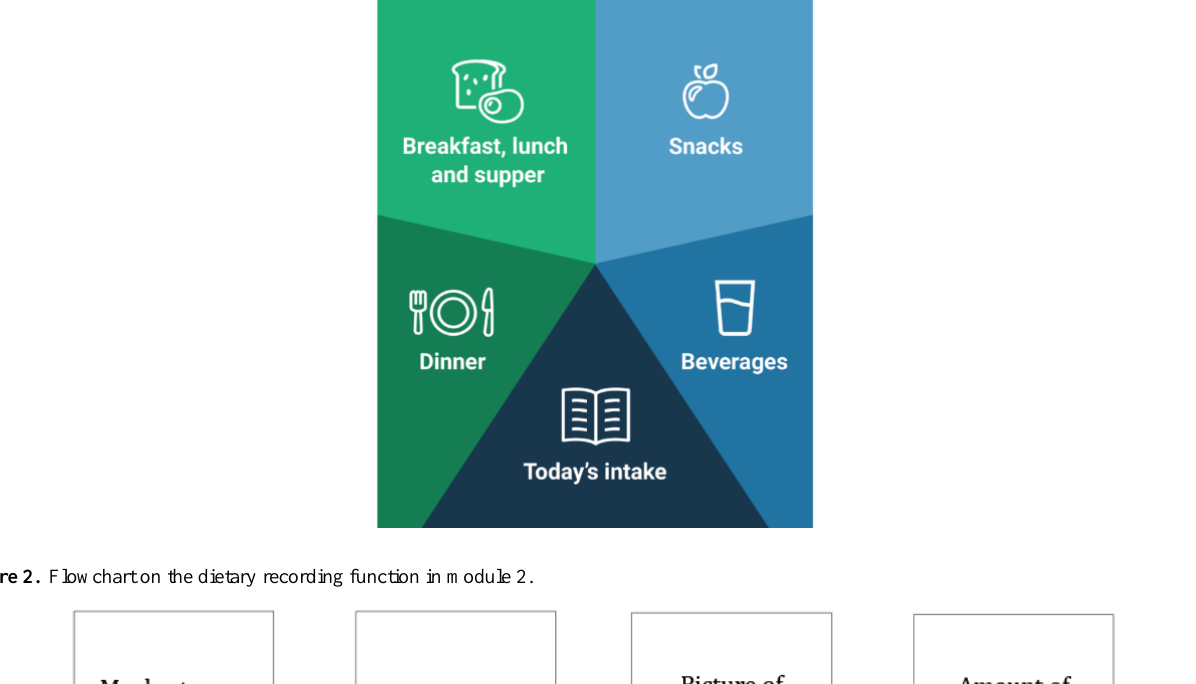
Figure 1. The main menu of dietary recording in the MyFood app.